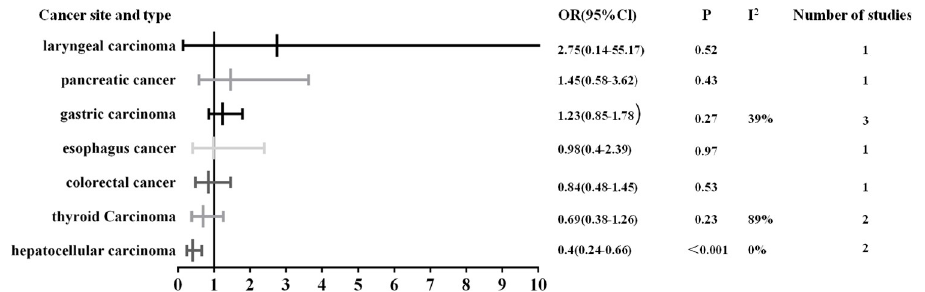
Fig 5. Summary risk estimates of clinical stage by cancer sites.